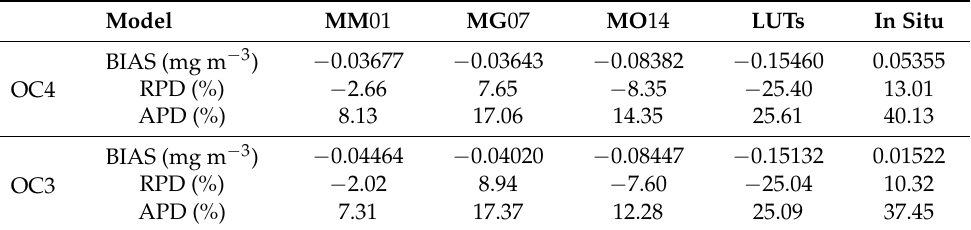
Figure 11. Performance of the MM01, MG07, MO14, and LUT models with the chlorophyll algorithm (OC3 and OC4, left) and comparison of OC4 algorithm between MM01 and in situ spectroscopy (right). Table 3. Statistical parameter of chlorophyll algorithm (OC3 and OC4) between MM01, MG07, MO14, and LUT models and in situ